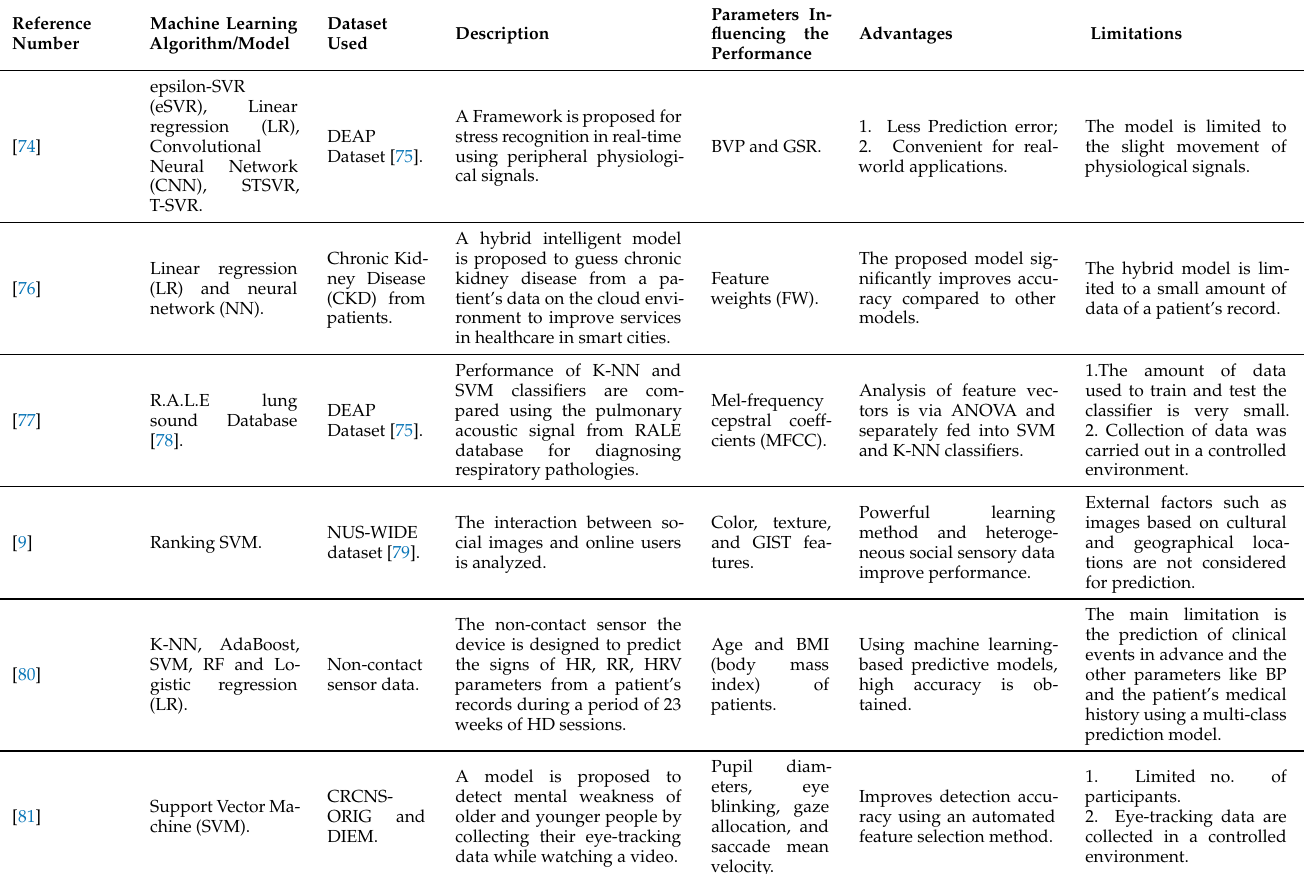
Table 3. Comparison of Machine Learning Algorithms/Models in Intelligent